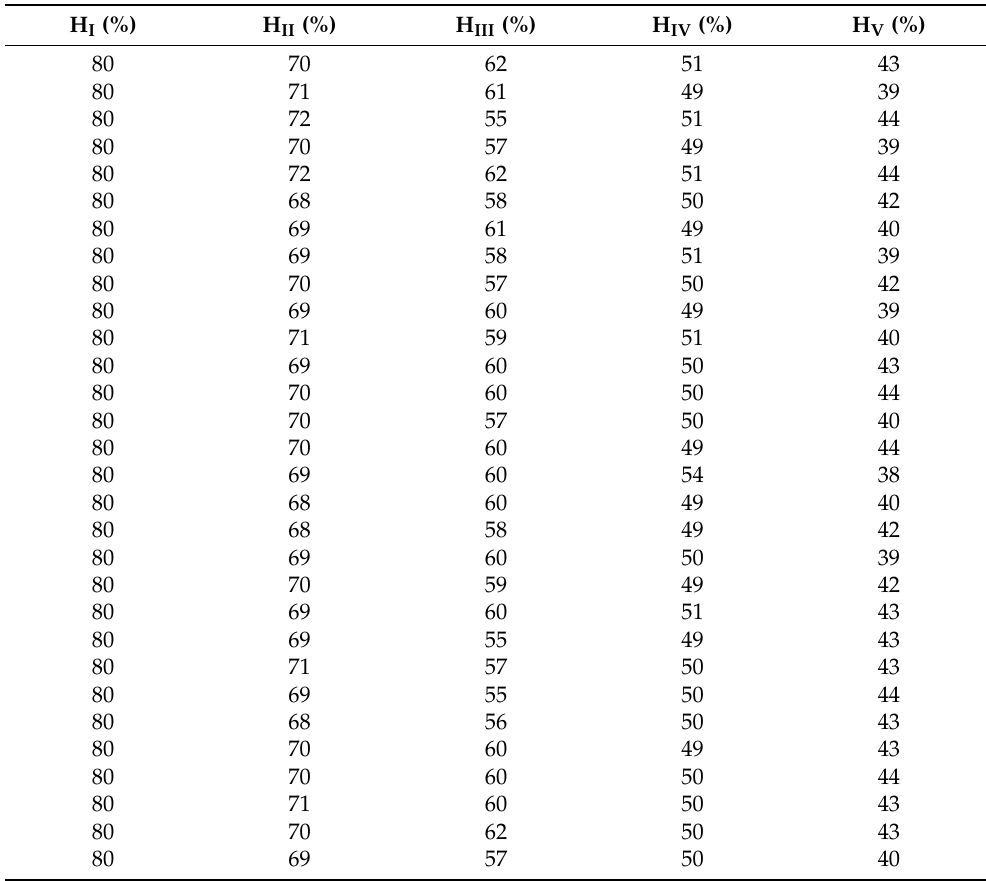
Table A1. Impulse heights on the ultrasonic flaw detector screen—determination of measurement errors in the unglued area.